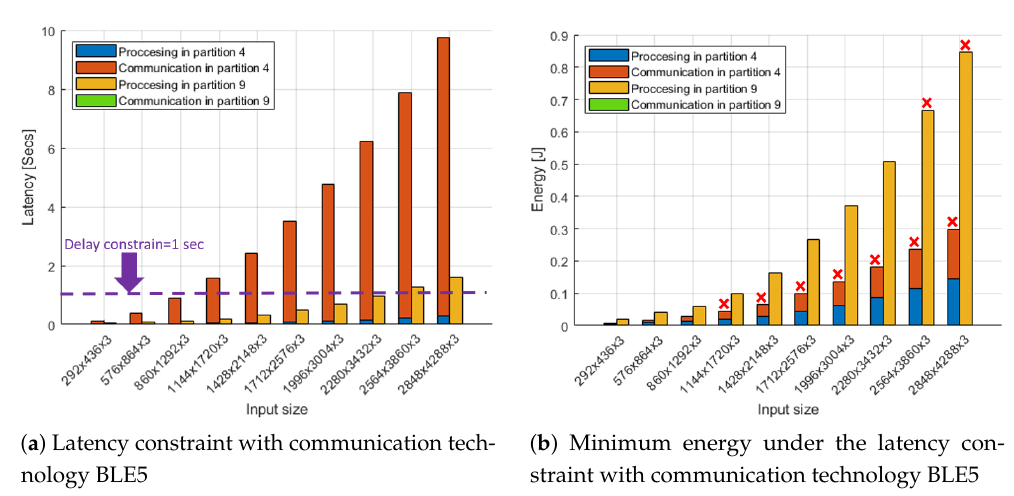
Figure 14. Contribution of the processing and communication components to the time and energy of partitions 4 and 9 depending on the image